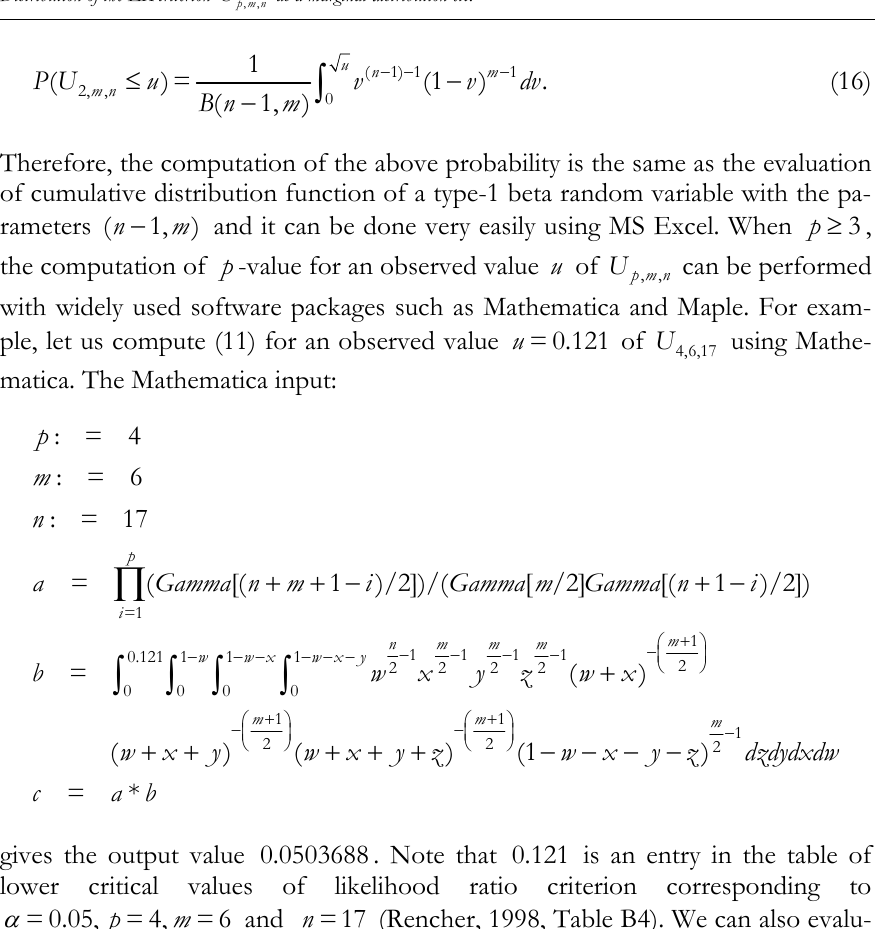
available in the literature and the table values obtained using the density (9) coin- cides with that of Table B4 of (Rencher, 1998), we are not reproducing the entire table values